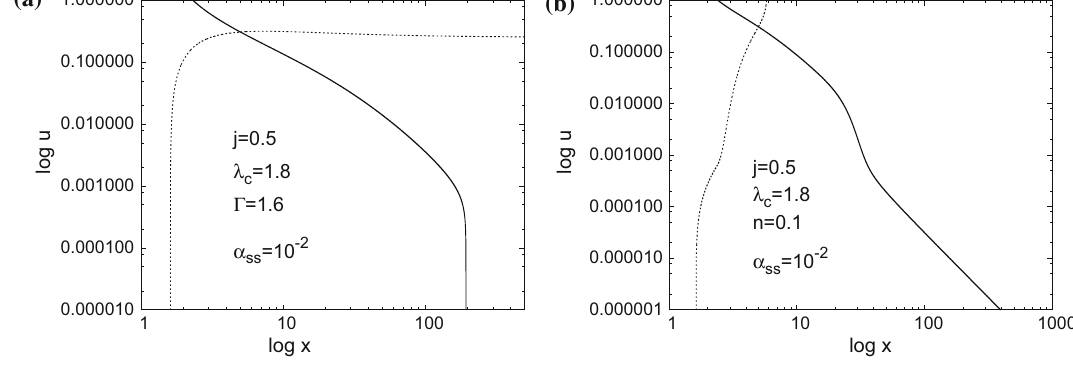
Fig. 6 a , b are plots of log( u ) vs. log( x ) for a viscous ( α ss = 10 − 2 ) accretion disc flow around a rotating BH (with specific angular velocity j = 0 . 5) for adiabatic and MCG, respectively. Accretion and wind curves are depicted by solid and dotted lines, respectively